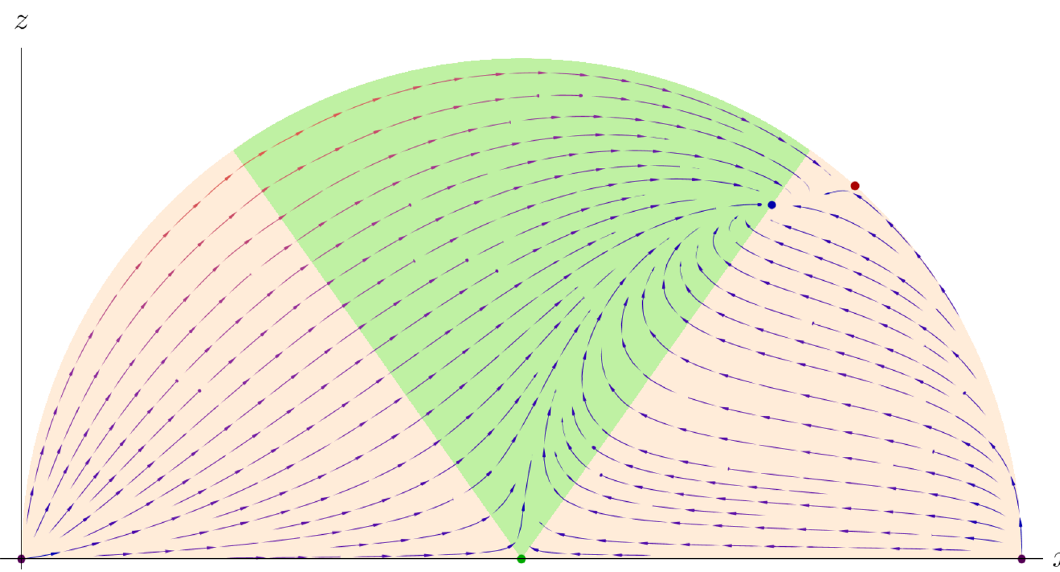
Figure 8 . Vector field generated by the dynamical system (6.6), plotted in the invariant plane P . Here, the acceleration region is a cone, depicted in green. The generic equator fixed points are illustrated in purple. This example corresponds to the case λ, k 6 = 0 , studied extensively in section 6.1, and coincides with the northern hemisphere of figure